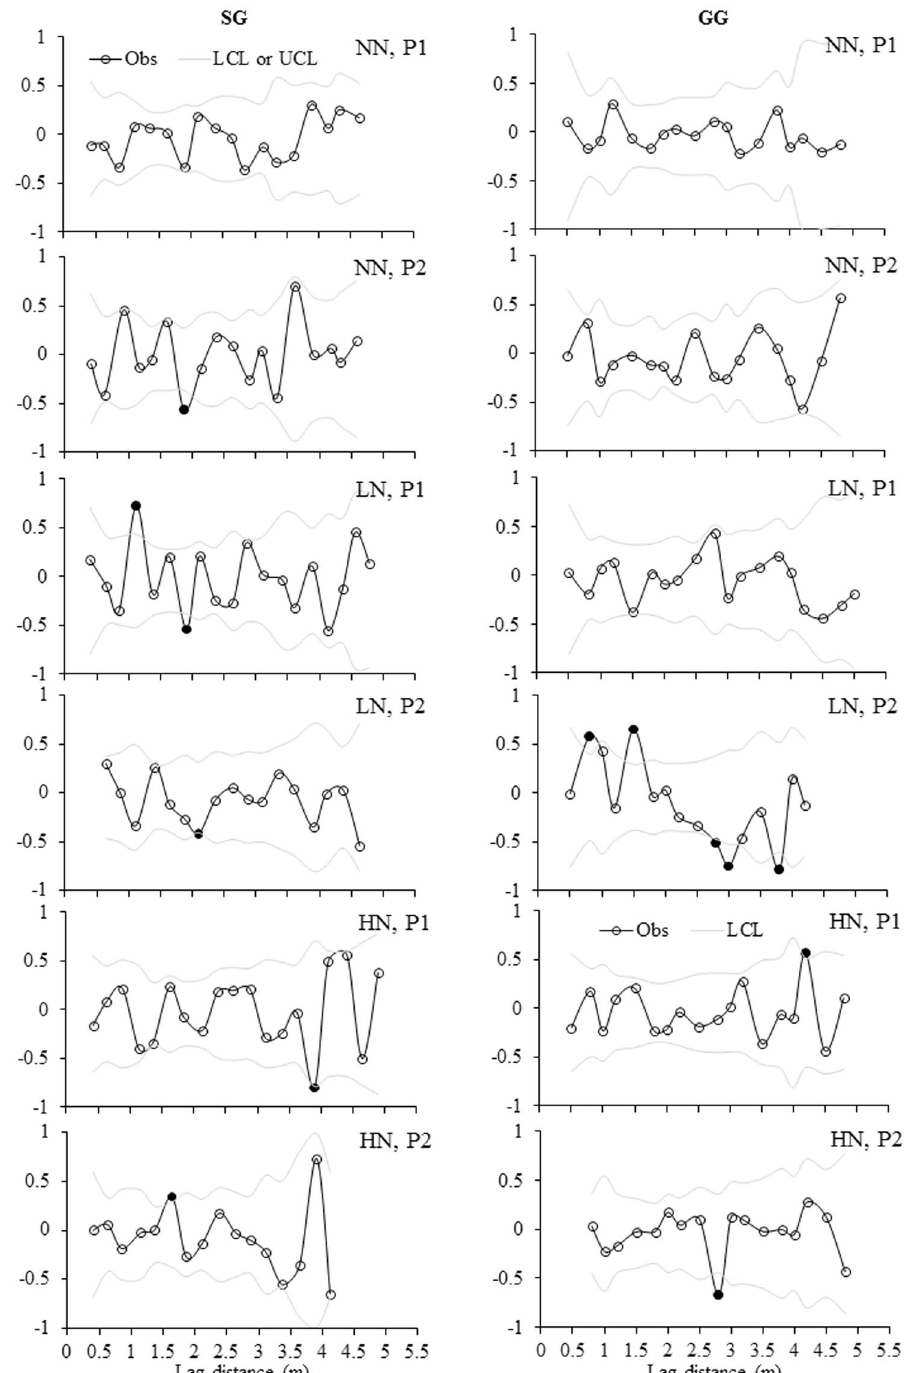
Figure 6. Moran’s I correlograms for soil MBN concentration under three N fertilization treatments (i.e. NN, LN and HN) in SG and GG cropland soils in a three-year long fertilization experimental site at the Tennessee State University (TSU) Agricultural Research Center in Nashville, TN, USA. Filled circles denote Moran’s I values that exhibited significant positive or negative autocorrelation. Obs: observations; LCL: low confident limit; and UCL: Upper conficence limit. Other abbreviations are referred to Table